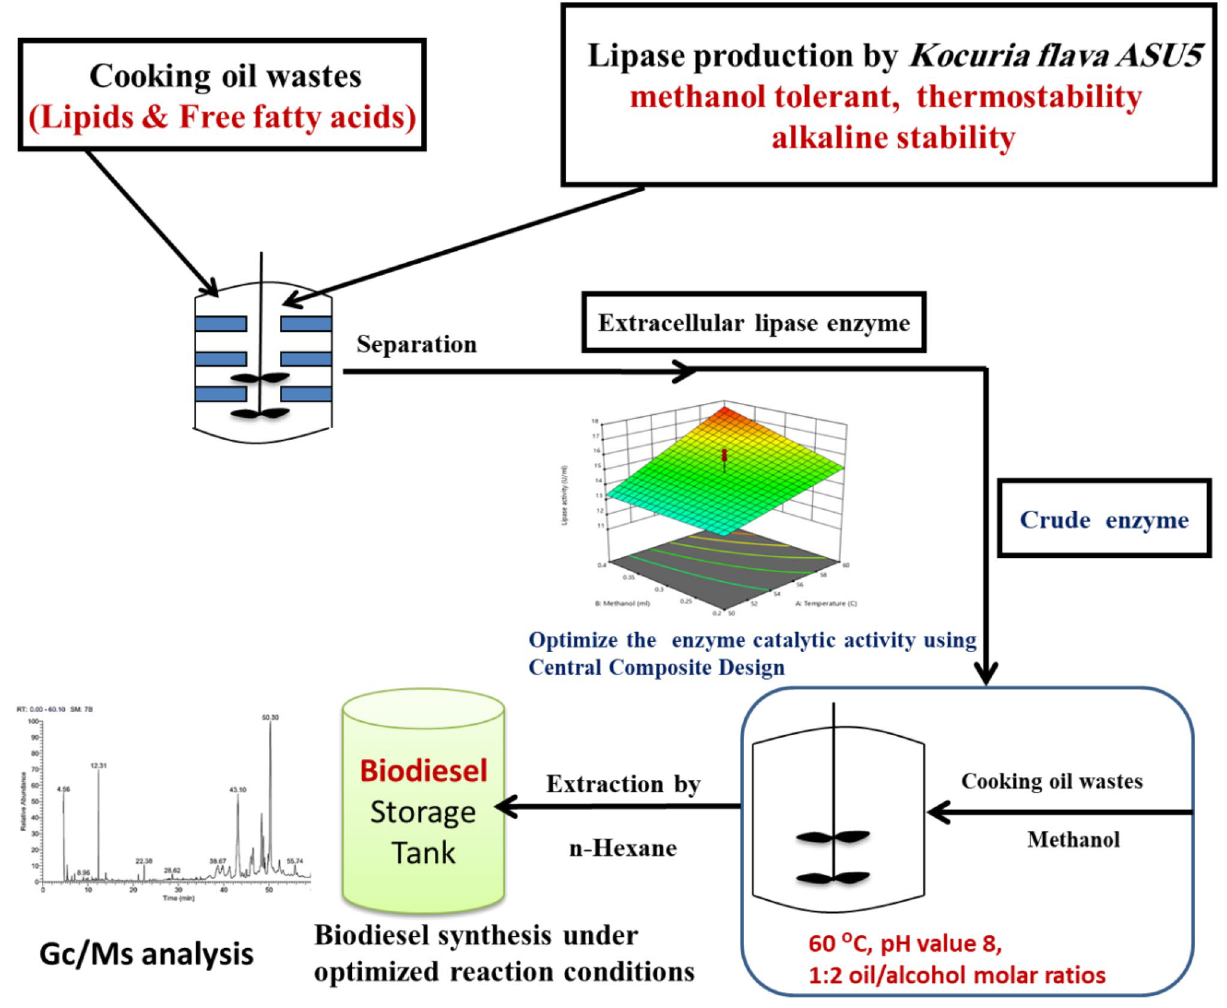
Figure 1. Graphical abstract showing overview of current work